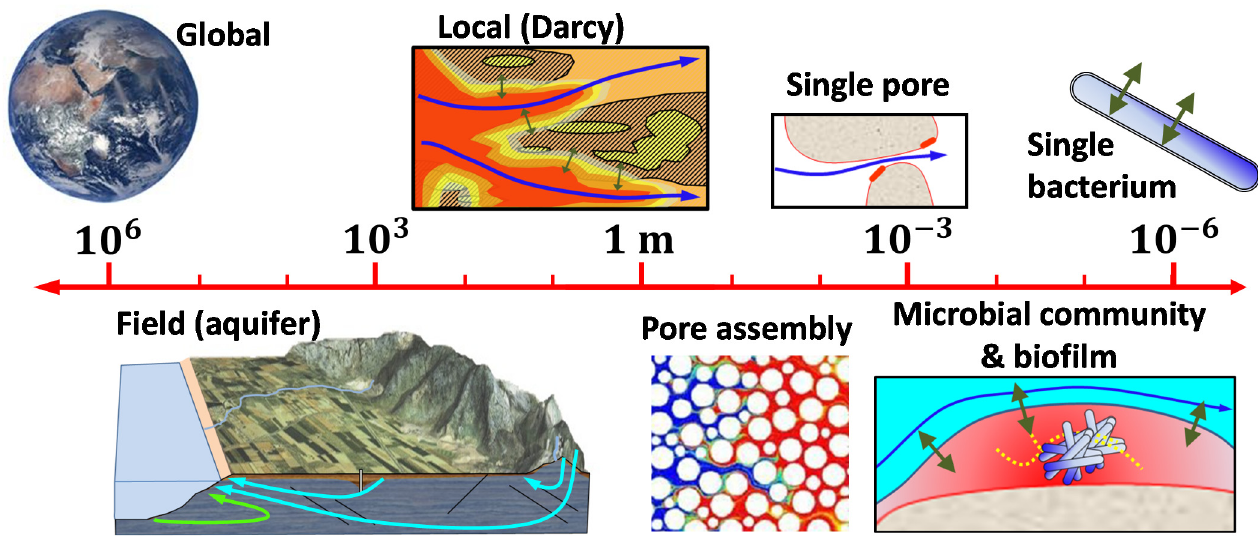
Figure 9. A broad range of scales are involved in RT. Continuum (i.e., Darcy) representations are standard above 1 m scales. Pore scales are becoming frequent below 10 cm scales. Recall that diffusion (double green arrows) dominates sub mm scales, while advection (blue arrows, always spatially variable) dominates large scales.